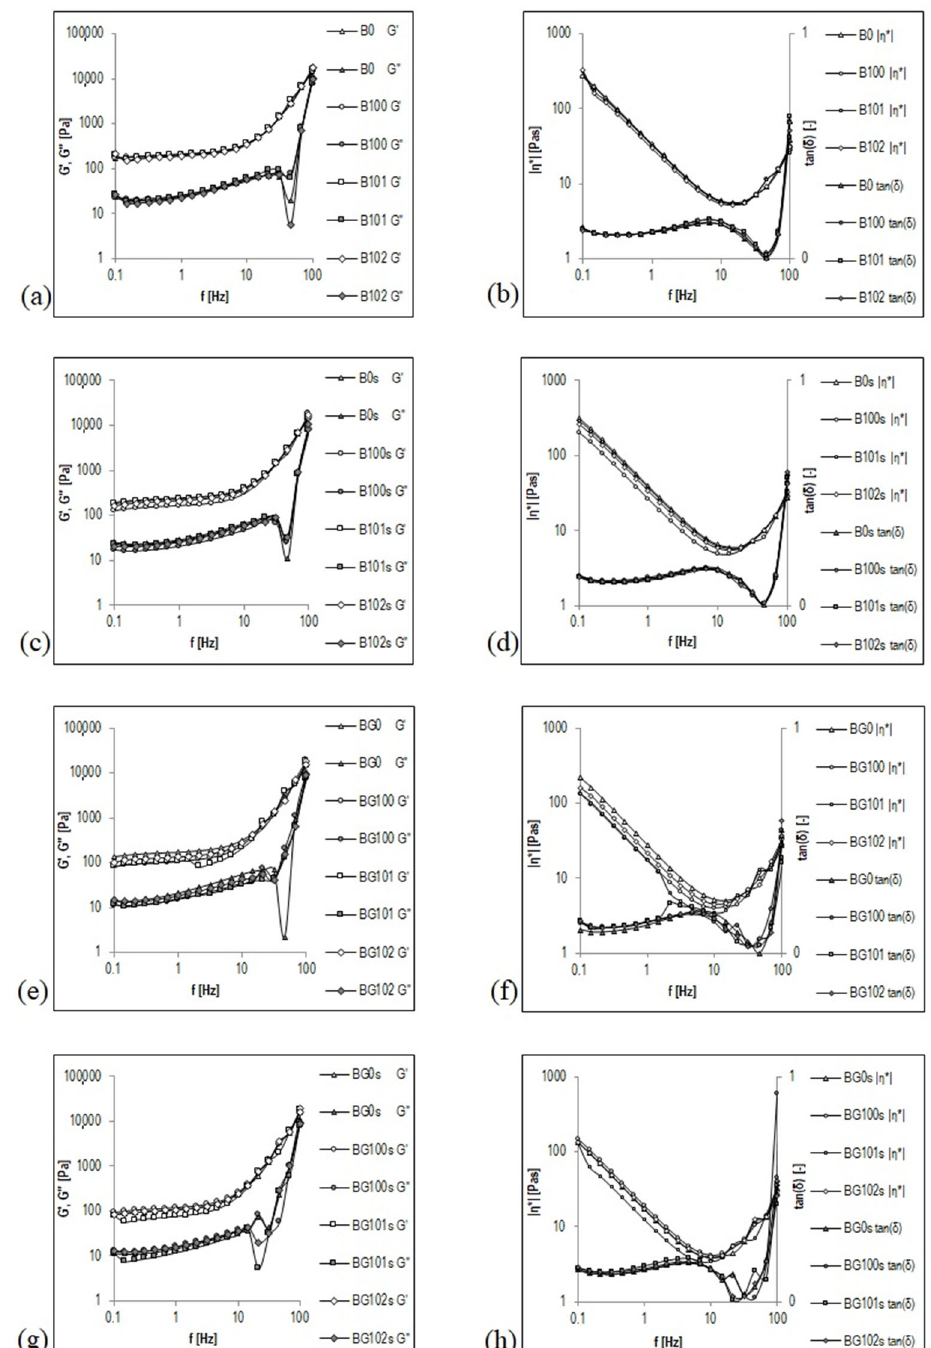
Figure 2. Mechanical spectra of germinated and non-germinated BBB presented graphically as functional relationships G (cid:48) , G (cid:48)(cid:48) , | η *|, and tan δ = f(Hz). Explanations: B/BG0, B/BG100, B/BG101, B/BG102—description as in Table 1.